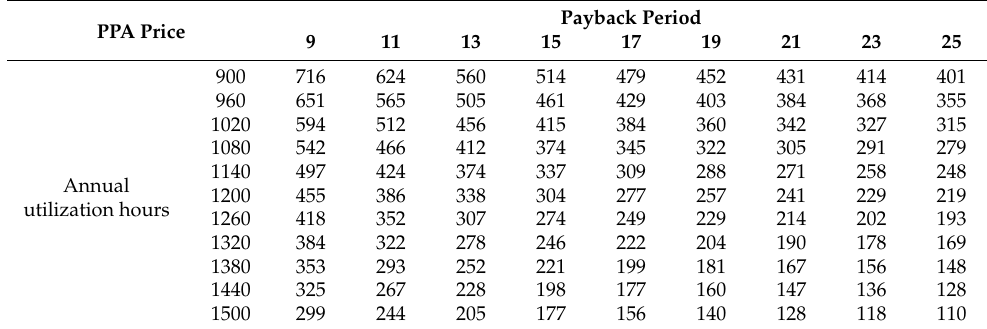
Table 4. Correlation Analysis of Utilization Hours, Payback Period and PPA